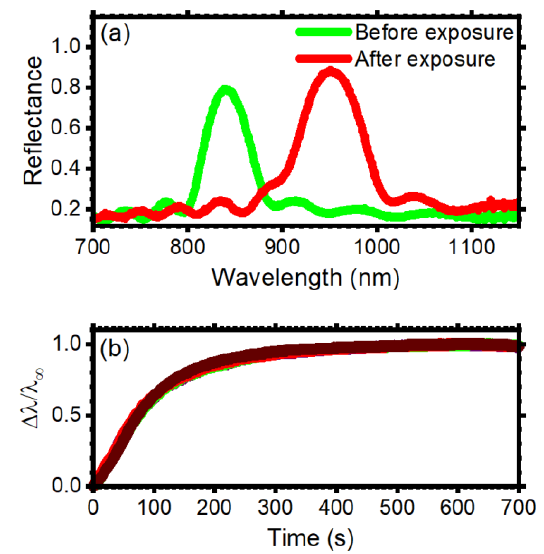
Fig. 2. Optical response of PS:CA DBR to exposure to methanol vapors. (a) Spectra collected before (green line) and after (red line line) the exposure. (b) Optical sorption curves extracted for the